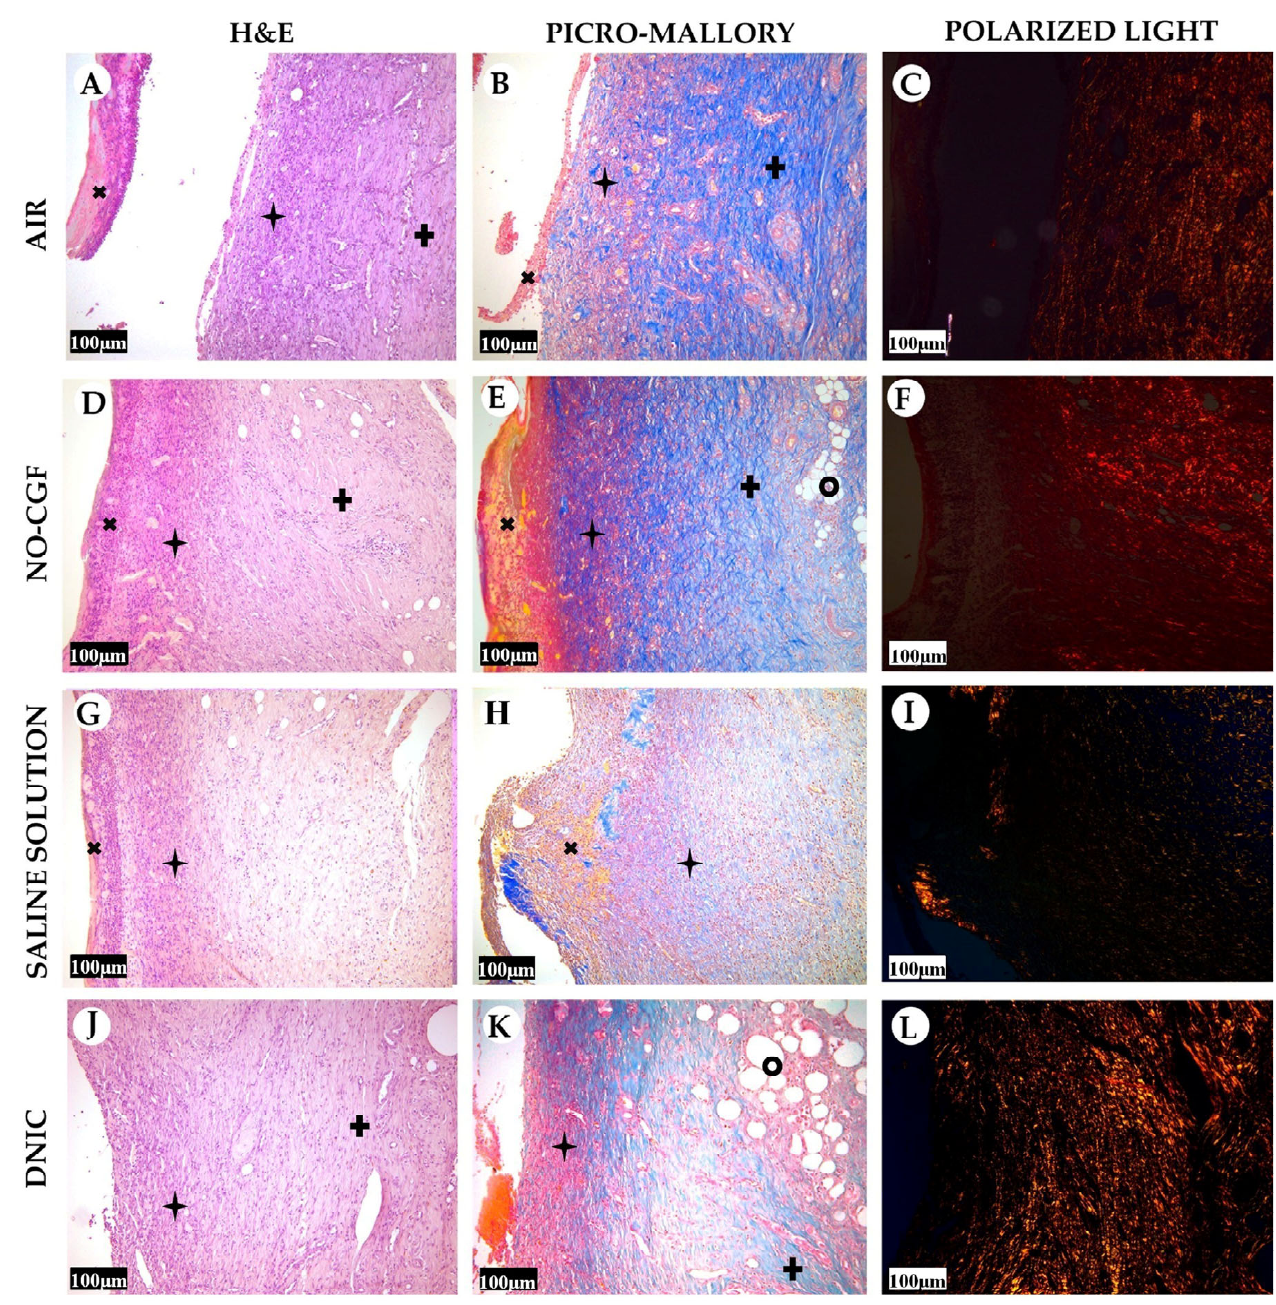
Figure 12. Histology of the wounds at post-operative day 14, hematoxylin and eosin